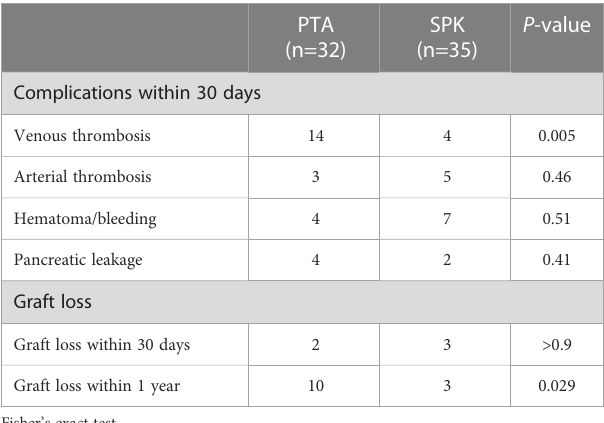
TABLE 2 Clinical outcome in PTA versus